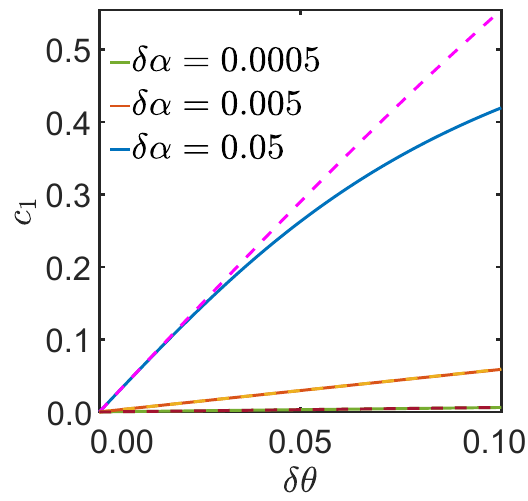
FIG. 7. The dependence of c 1 on δθ near θ = π for δα = 0.0005, 0.005, and 0.05, and which corresponds to t h /δα = 34, 3.4, and 0.34 at R = 2.9. We see that for δα such that t h /δα ≤ 1, the weight c 1 increases linearly with δθ , matching well the geo- metric limit in Eq. (E3), represented by the dashed lines, for a wide range of deviations δθ